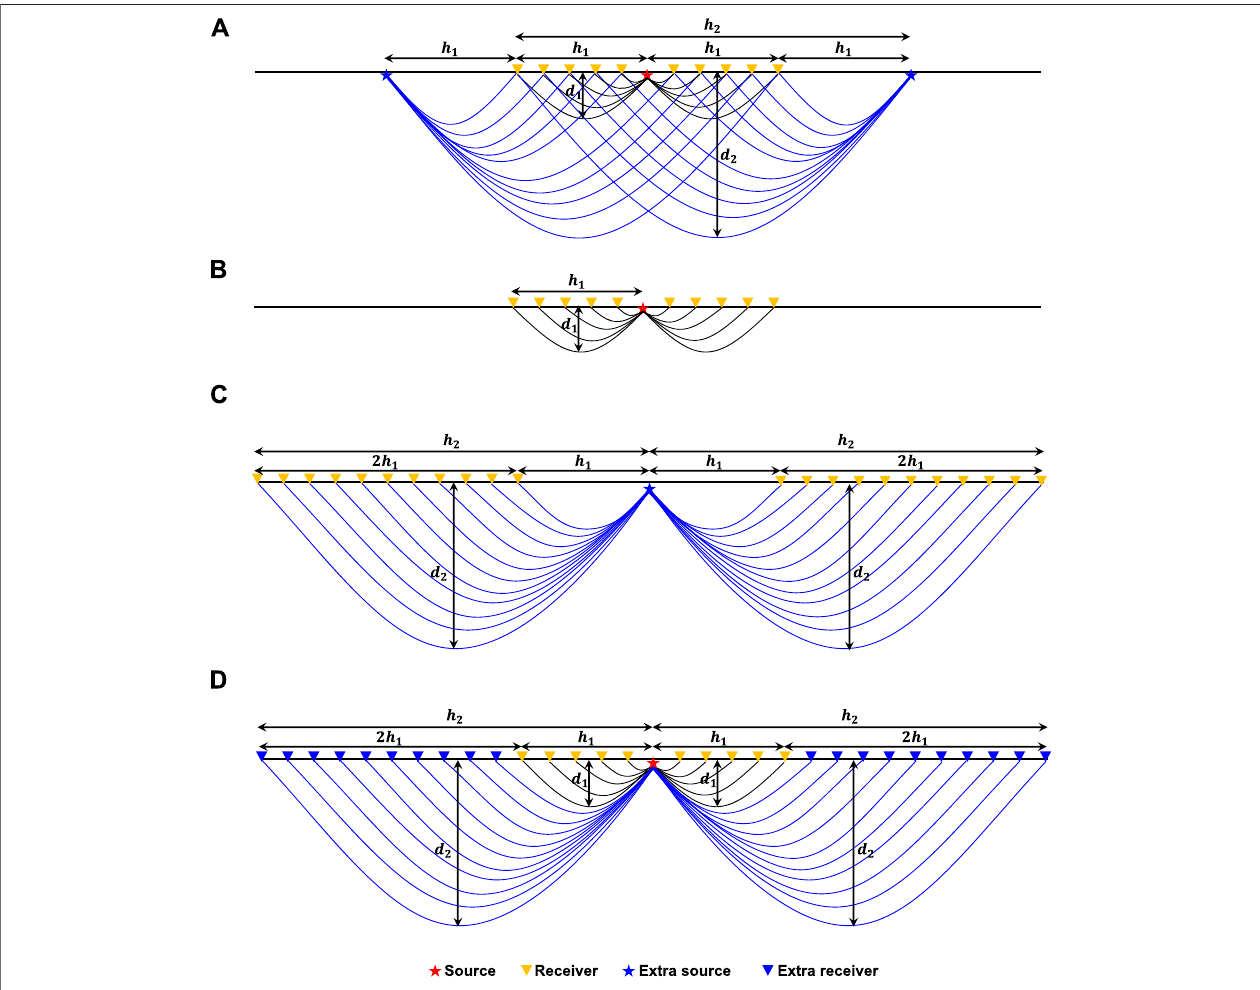
FIGURE4| Equivalencebetweenthetwotypesofmodi fi edgeometry. (A) Type-Imodi fi edgeometrywithonlytwoextrasourcesaddedattwoends.Thisgeometry is equal to the summation of (B) and (C) . Consequently, Type-I geometry is equivalent to a Type-II geometry shown in (D) . h 1 represents the maximum offset of the receiverarrayforthenormalgeometrypart.Italsodenotestheoffsetoftheextrasourcestothenearestreceivers. h 2 indicatesthemaximumoffsetgeneratedbytheextra sources. d 1 and d 2 represent the maximum penetration depth of the diving waves recorded by the receivers in the normal geometry and extra sources and receivers,